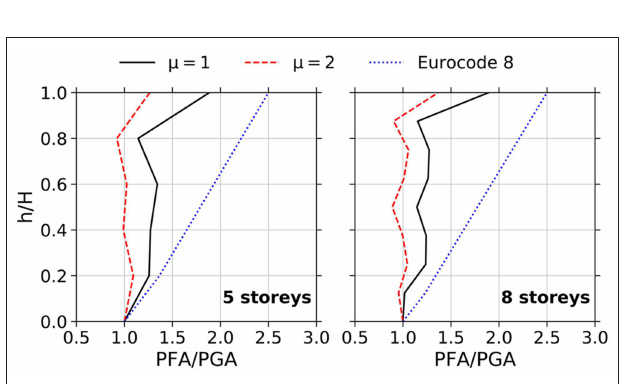
FIGURE 9 | Example of PFA to PGA across multiple ductility demands (archetypes of building config.